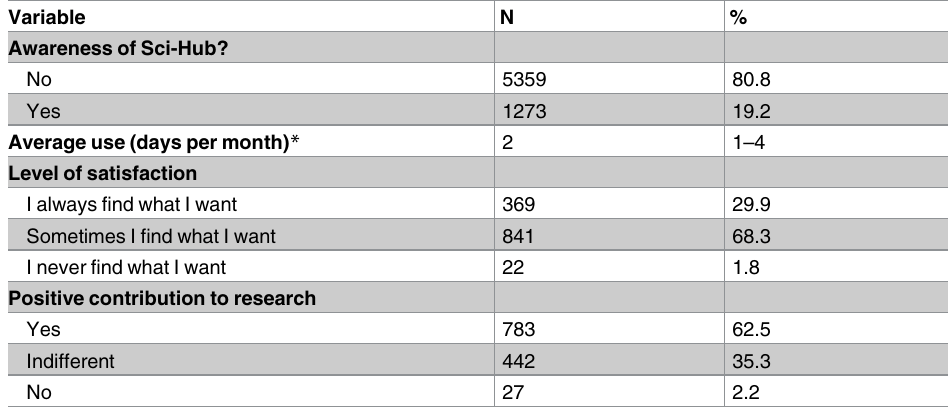
Table 2. Usage of Sci-Hub amongst medical students from 6 Latin American